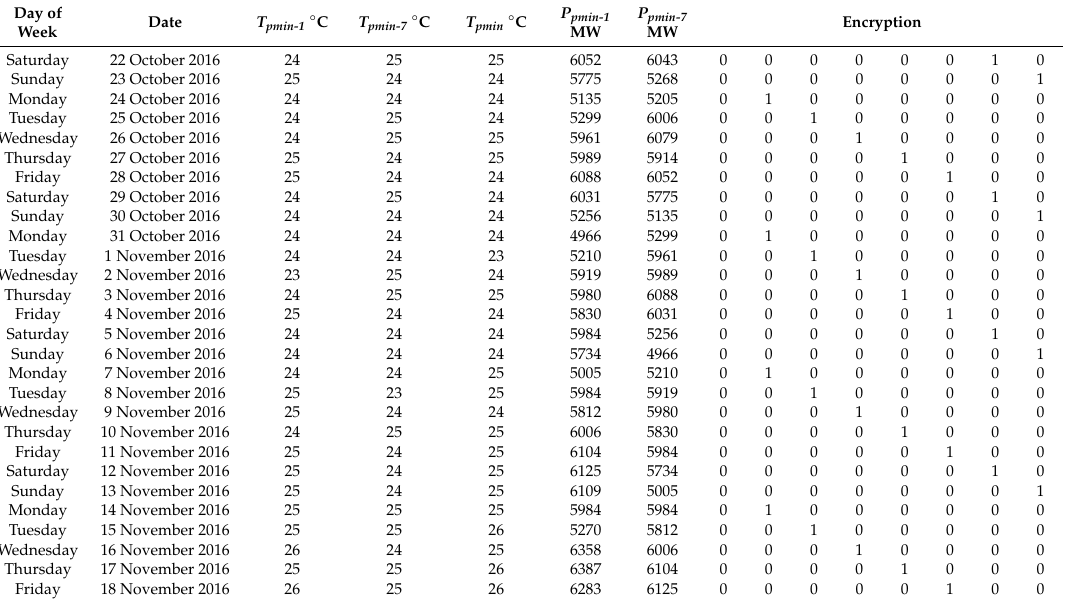
Table 4. The input data for valley load training.